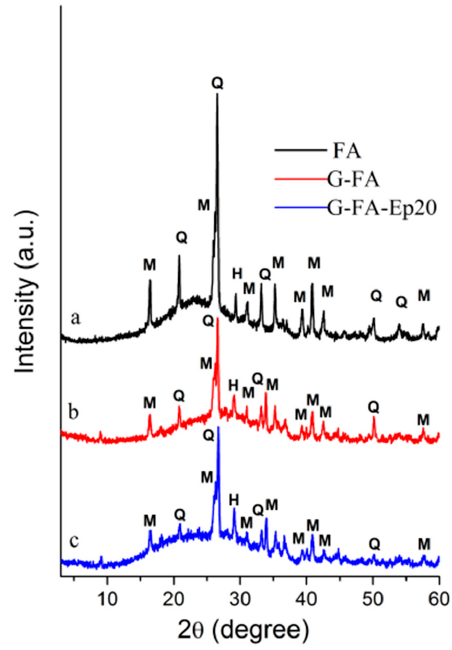
Figure 3. X-ray powder diffraction patterns of ( a ) the fly ash (FA; black line); ( b ) the cured neat geopolymer (G-FA; red line); and ( c ) the composite sample (G-FA-Ep20; blue line). H = hematite; M = mullite; Q = quartz.